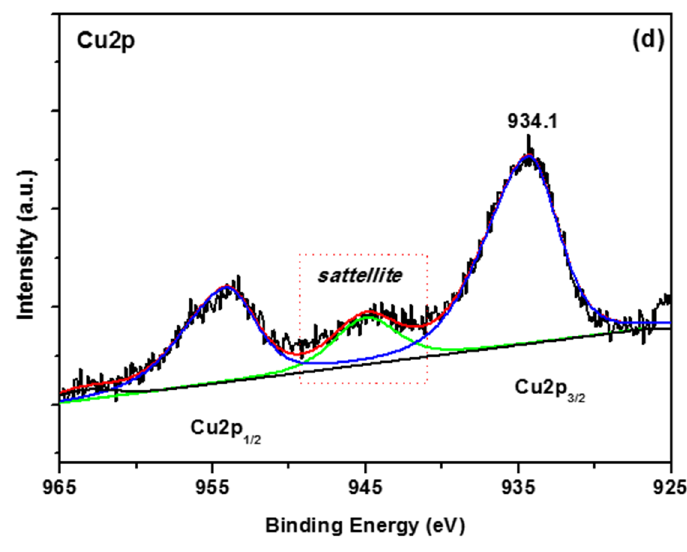
Figure 3. Core level 2p spectra of 20 wt.% Fe ( a ); Co ( b ); Ni ( c ) and Cu ( d ) catalysts supported on CeO 2 .